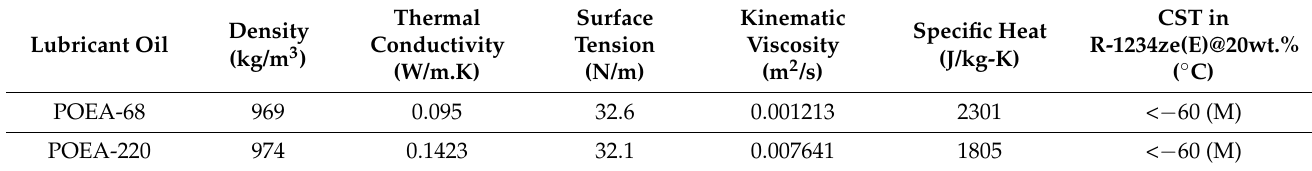
Table 1. Thermophysical properties of POE oil at 0 ◦ C. (M = Miscible, CST = Critical solution temperature).